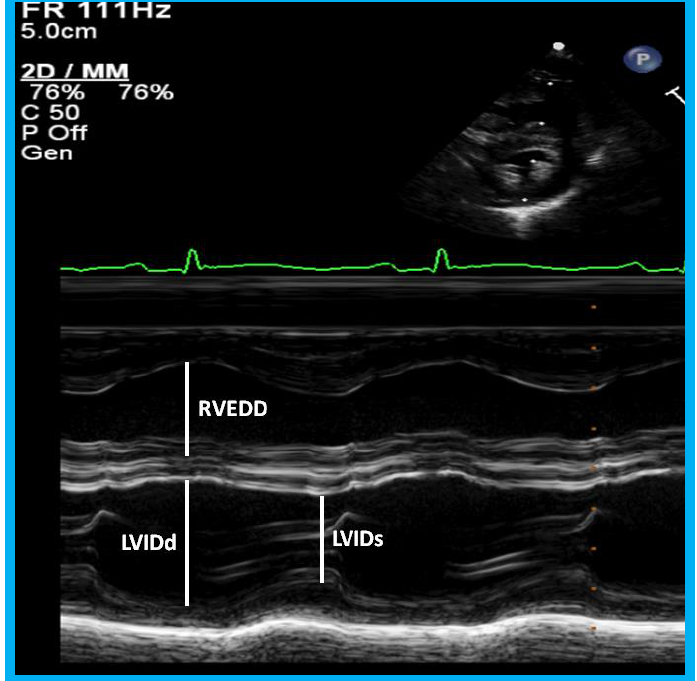
Figure 23. M-mode recording of the ventricles demonstrating measurements of left ventricular internal dimension in end-diastole (LVIDd) and right ventricular end-diastolic dimension (RVEDD), both measured at the onset of the QRS complex of the simultaneously recorded electrocardiogram (ECG): The left ventricular internal dimension in systole (LVIDs) is measured at end-systole. The data are compared with normal values, and z score is determined. These data are also used for calculation left ventricular fractional shortening: FS = {(LVIDd−LVIDs)/LVIDd} 100 (where FS is fractional shortening, LVIDd is left ventricular end-diastolic dimension, and LVIDs is left ventricular end-systolic dimension.) to assess the left ventricular systolic function.